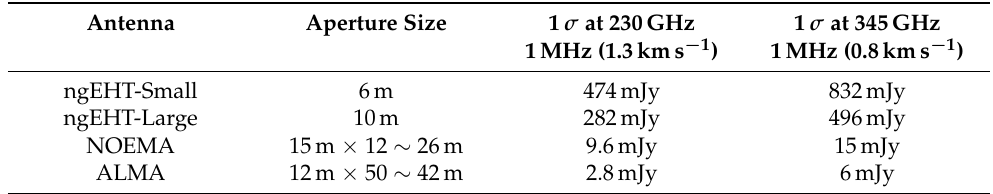
Table 1. Single-dish spectral line sensitivity of ngEHT stations with an integration time of 15 min at 230GHz and 345GHz, respectively. Antenna Aperture Size 1 σ at 230GHz 1 σ at 345GHz 1MHz (1.3kms − 1 ) 1MHz (0.8kms − 1 ) ngEHT-Small 6m 474mJy 832mJy ngEHT-Large 10m 282mJy 496mJy NOEMA 15m × 12 ∼ 26m 9.6mJy 15mJy ALMA 12m × 50 ∼ 42m 2.8mJy 6mJy